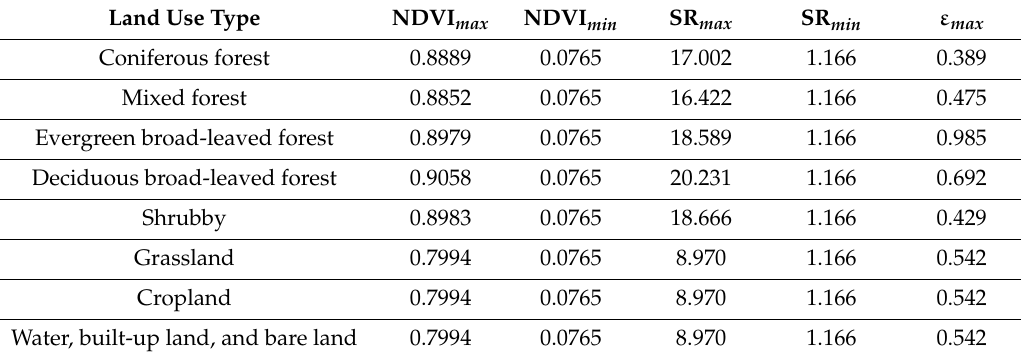
Table 2. Parameters of the CASA model for di ff erent land use